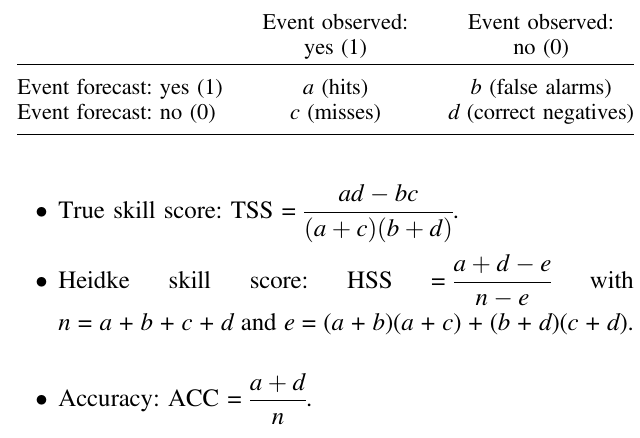
Table A.1. Contingency table for deterministic (yes/no) forecasts and event